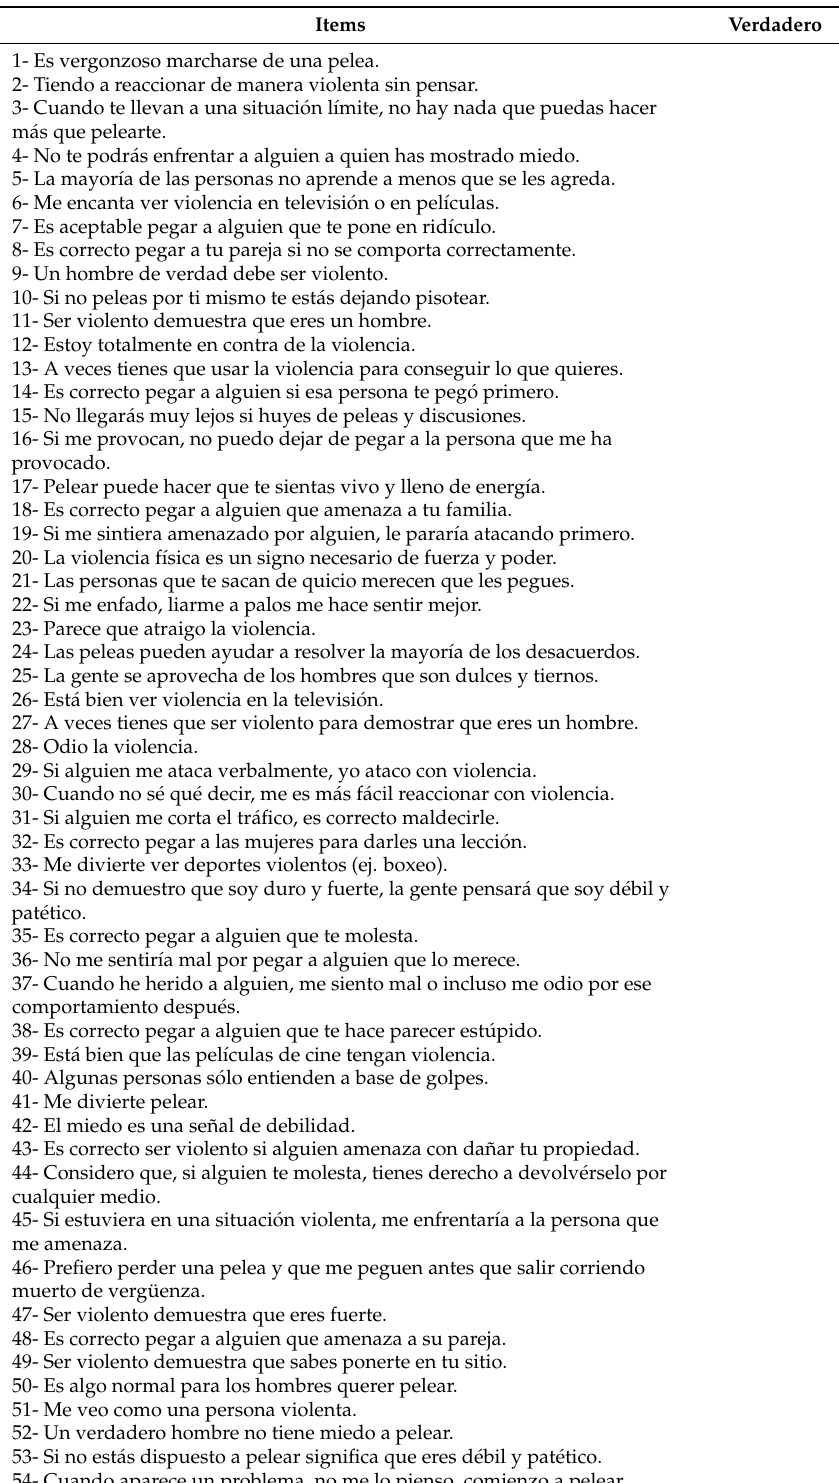
Table A1. Spanish version of the items of Maudsley Violence Questionnaire